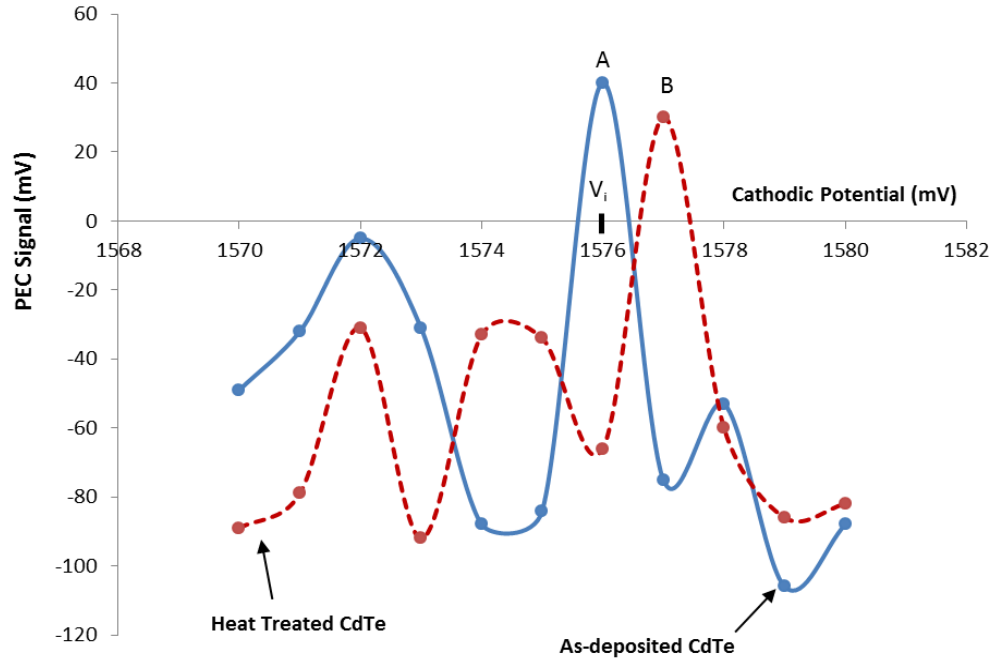
2 is present, but note the sample A, 2 ≈ N . Defect A D